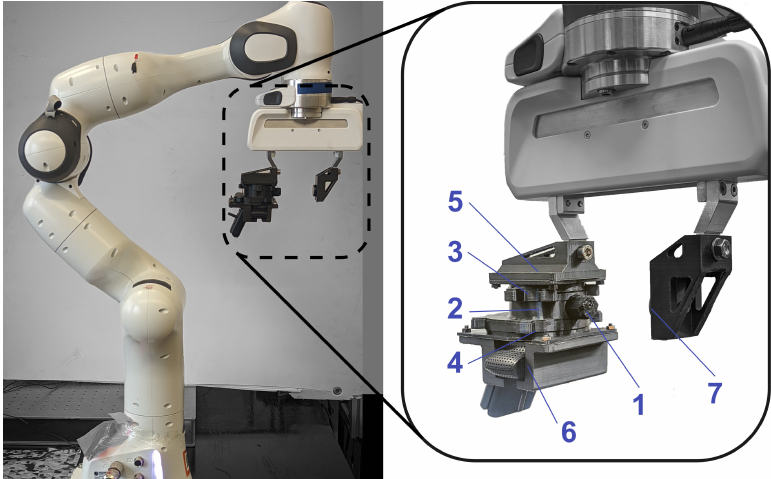
Figure 3. Test bench with PhotoElasticFinger: 1—sensing tip (tough silicone rubber), 2—transparent photoelastic layer (soft silicone rubber), 3 and 4—a pair of polarizers with orthogonal po- larization planes, 5—light source, 6—RGB camera, and 7—calibration device (WITTENSTEIN force/torque sensor). The exploded view of the sensor is provided in Appendix B Figure A3 and in Supplementary